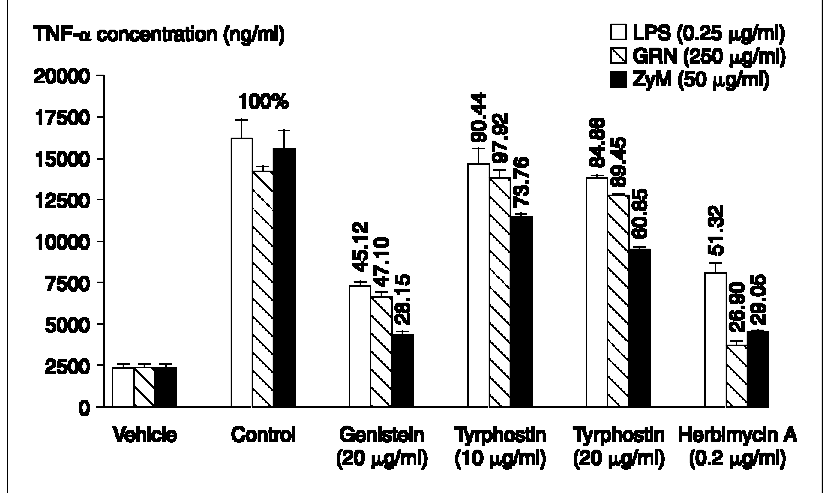
Fig. 2. Effect of tyrosine kinase inhibitors on the production of tumor necrosis factor (TNF)- a by RAW264.7. LPS, lipopolysaccharide; GRN, grifolan; ZyM, zymosan.